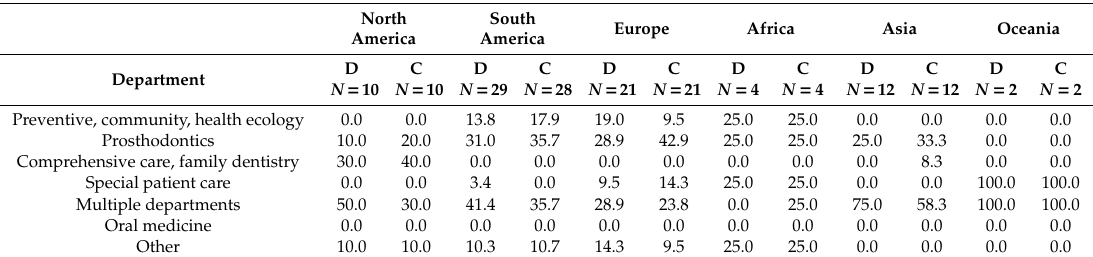
Table 3. Departments responsible for teaching didactic (D) ( N = 78) and clinical (C) ( N = 77) geriatric